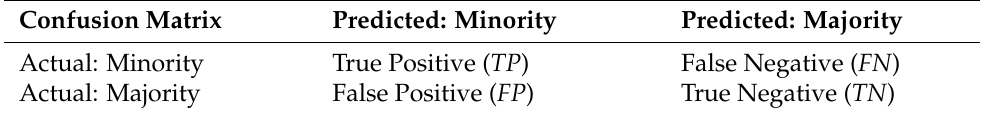
Table 6. The confusion